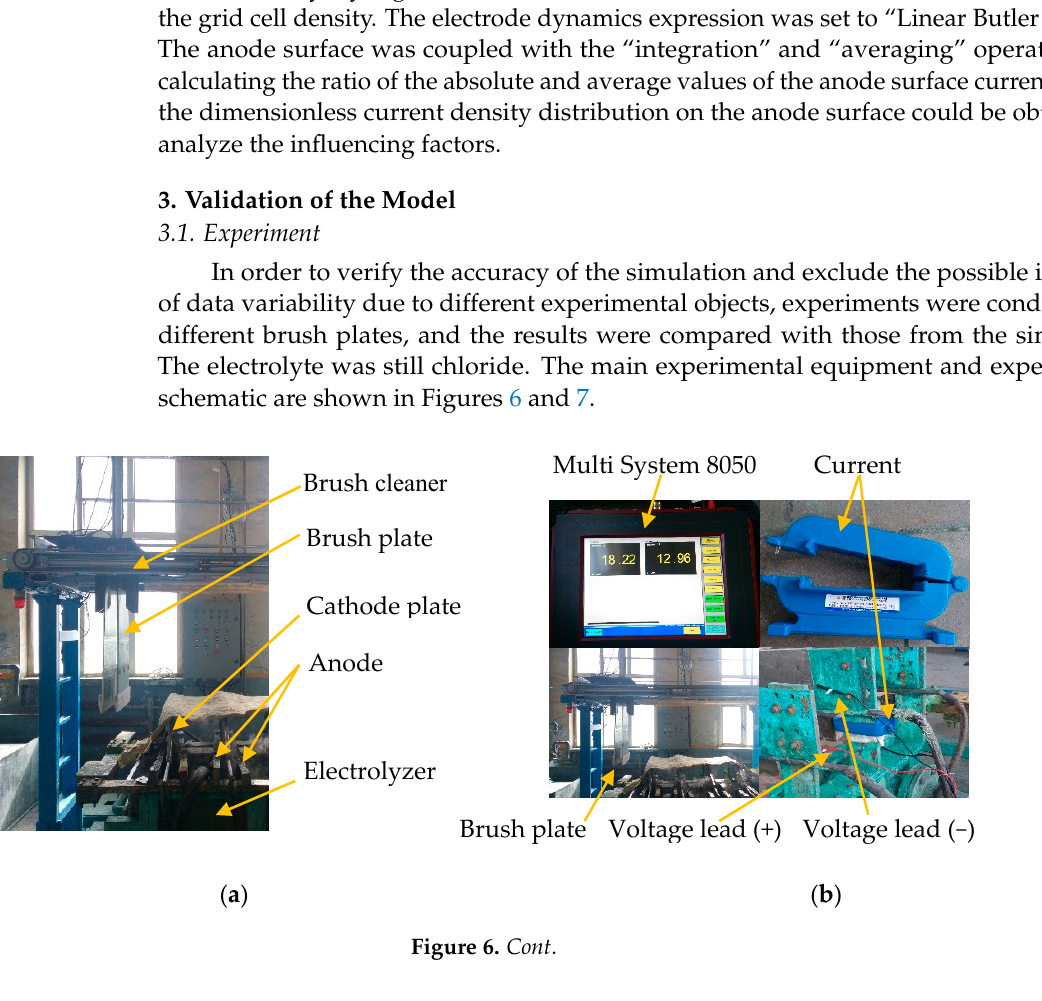
Table 1. Cathode and anode boundary.